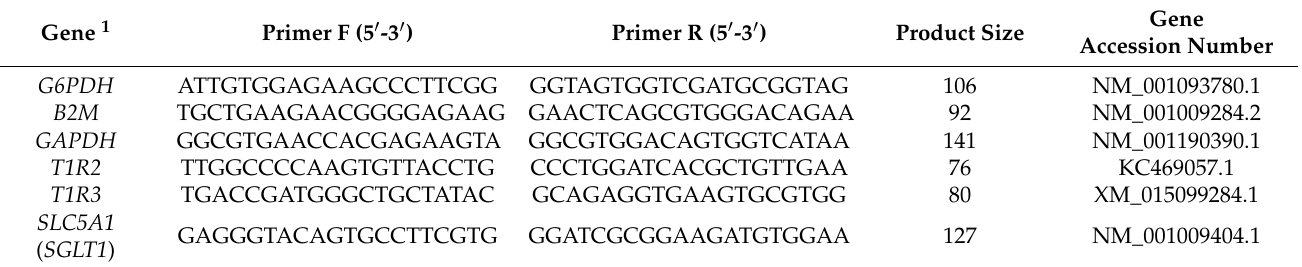
Table 2. Primers used for the real-time PCR analysis of gene expression in the proximal